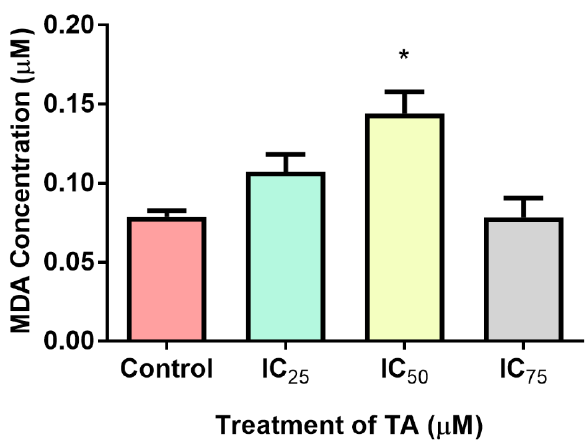
Figure 3. Malondialdehyde (MDA) concentration of Hek-293 cells at IC 25 , IC 50 and IC 75 treatments. Tannic acid induced oxidative stress at IC 25 (1.3-fold), with a 1.8-fold rise at IC 50 , as indicated by the elevated MDA concentrations. ROS production remained almost unchanged at IC 75 relative to the control. (* p < 0.05).